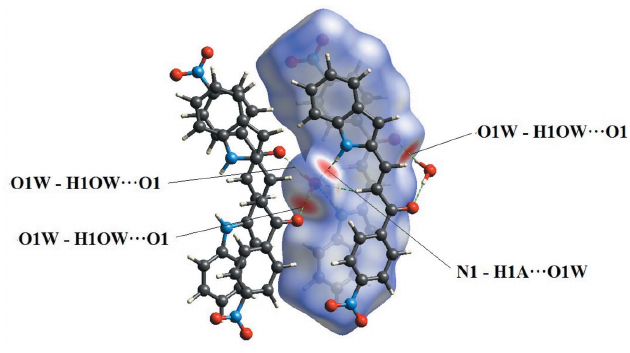
Figure 4 Hirshfeld surface of the title compound mapped over d norm .